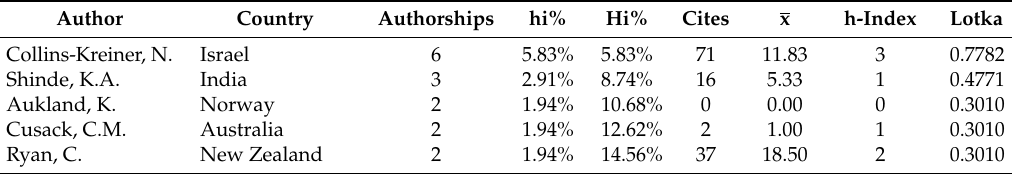
Table 4. Most productive